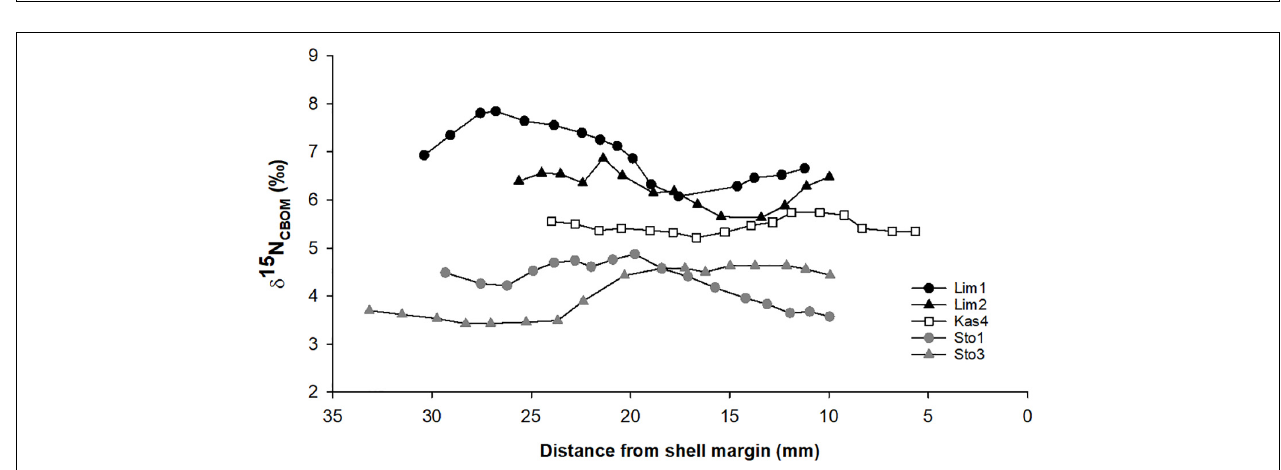
FIGURE 5 | Predicted shell oxygen isotope values (gray line) obtained from the temperature (ROMS model) and δ 18 O water estimates based on salinity (ocean model) using the paleothermometry equation by Killingley and Newman (1982). Gray circles represent temporally aligned δ 18 O shell values of Pinna nobilis specimen Kas1 collected alive at Kaštela Bay in January 2020; green diamonds represent corresponding δ 15 N CBOM values. Scale on y1-axes is reversed.